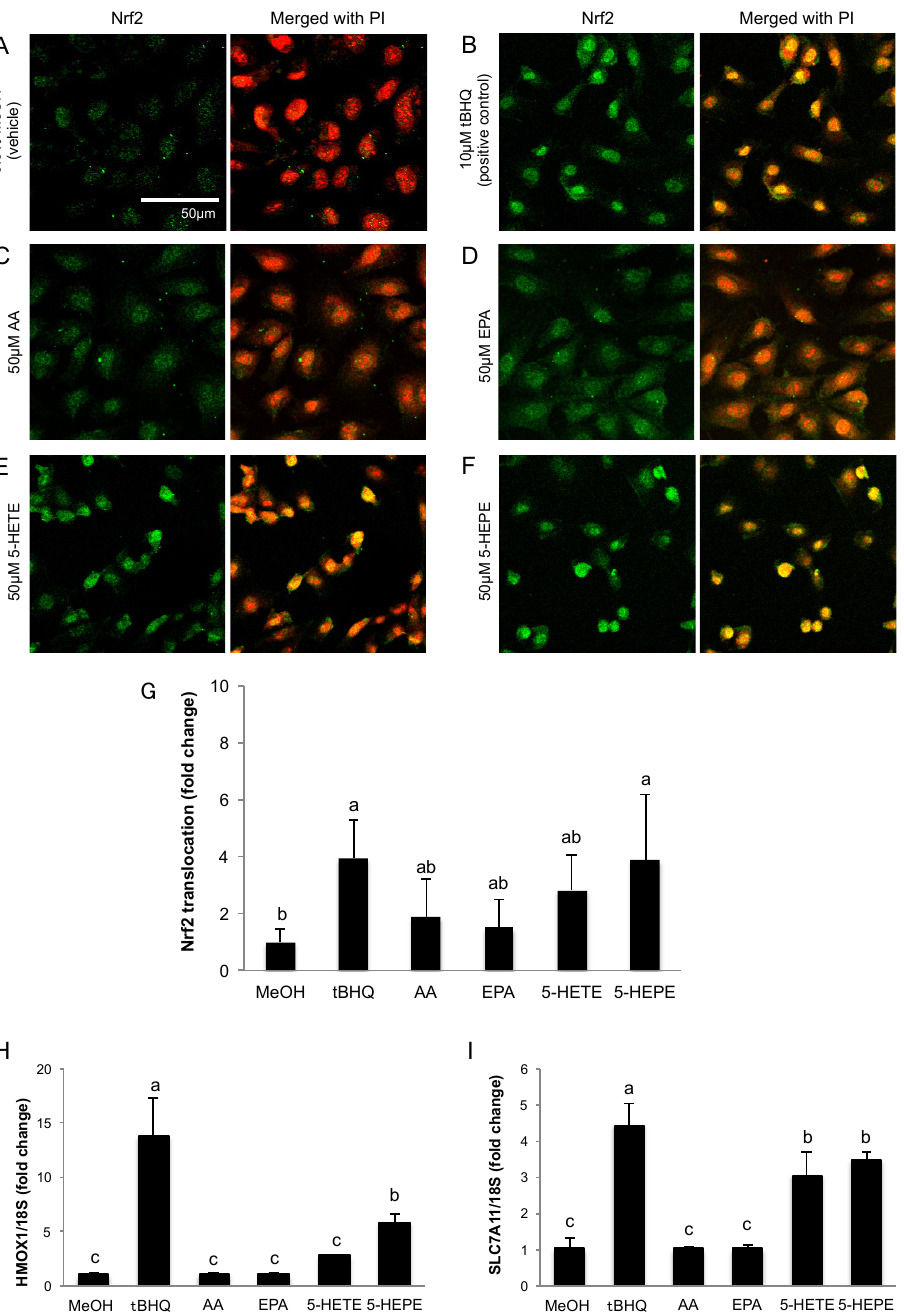
Figure 1. Effects of hydroxy fatty acids on Nrf2 translocation and expression of genes regulated by the Keap1-Nrf2 pathway in HUVECs. Nrf2 translocation was detected by immunostaining (green), and the nuclei were stained with PI (red). Cells were treated for 3 h with: 0.5% MeOH (vehicle) ( A ); 10 µ M tBHQ ( B ); 50 µ M AA ( C ); 50 µ M EPA ( D ); 50 µ M 5-HETE ( E ); and 50 µ M 5-HEPE ( F ). The intensity of the green fluorescence signal in the nucleus was quantified using Image J ( G ). Data are expressed as the mean ± standard deviation (SD) ( n = 10). Significant differences among the groups are indicated with different letters (one-way ANOVA followed by Tukey’s test, p < 0.05). Gene expression levels of: HMOX1 ( H ); and SLC7A11 ( I ) in HUVECs were analyzed and normalized to 18S gene expression levels (as an internal control) after incubation of each sample for 6 h. Data are expressed as mean ± SD ( n = 4). Significant differences among the groups are indicated with different letters (one-way ANOVA followed by Tukey’s test, p < 0.05). Abbreviations: Nrf2, NF-E2 related factor 2; Keap1, Kelch-like ECH-associated protein 1; HUVEC, human umbilical vein endothelial cell; PI, propidium iodide; MeOH, methanol; tBHQ, tert-butylhydroquinone; AA, arachidonic acid; EPA, eicosapentaenoic acid; 5-HETE, 5-hydroxyeicosatetraenoic acid; 5-HEPE, 5-hydroxyeicosapentaenoic acid; ANOVA, analysis of variance; and HMOX1, heme oxygenase